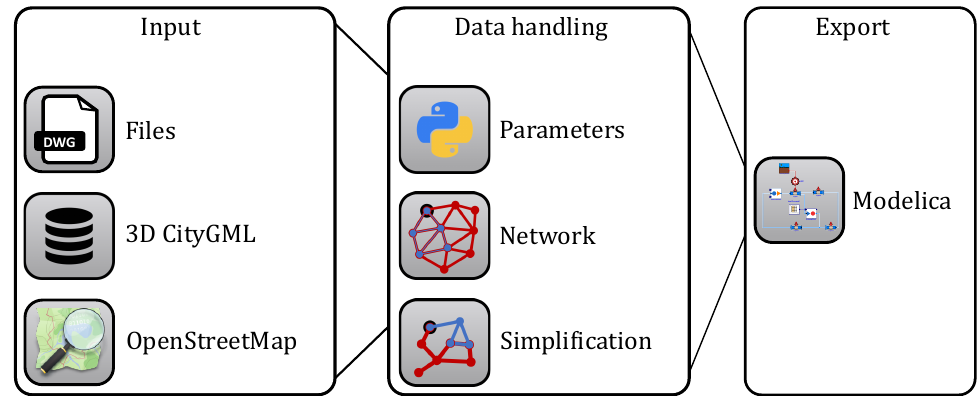
Figure 2. Overview of uesgraphs workflow: Exemplary input data with geospatial information which can be used to create a graph, the data storage and data handling afterwards, the Modelica model export in the